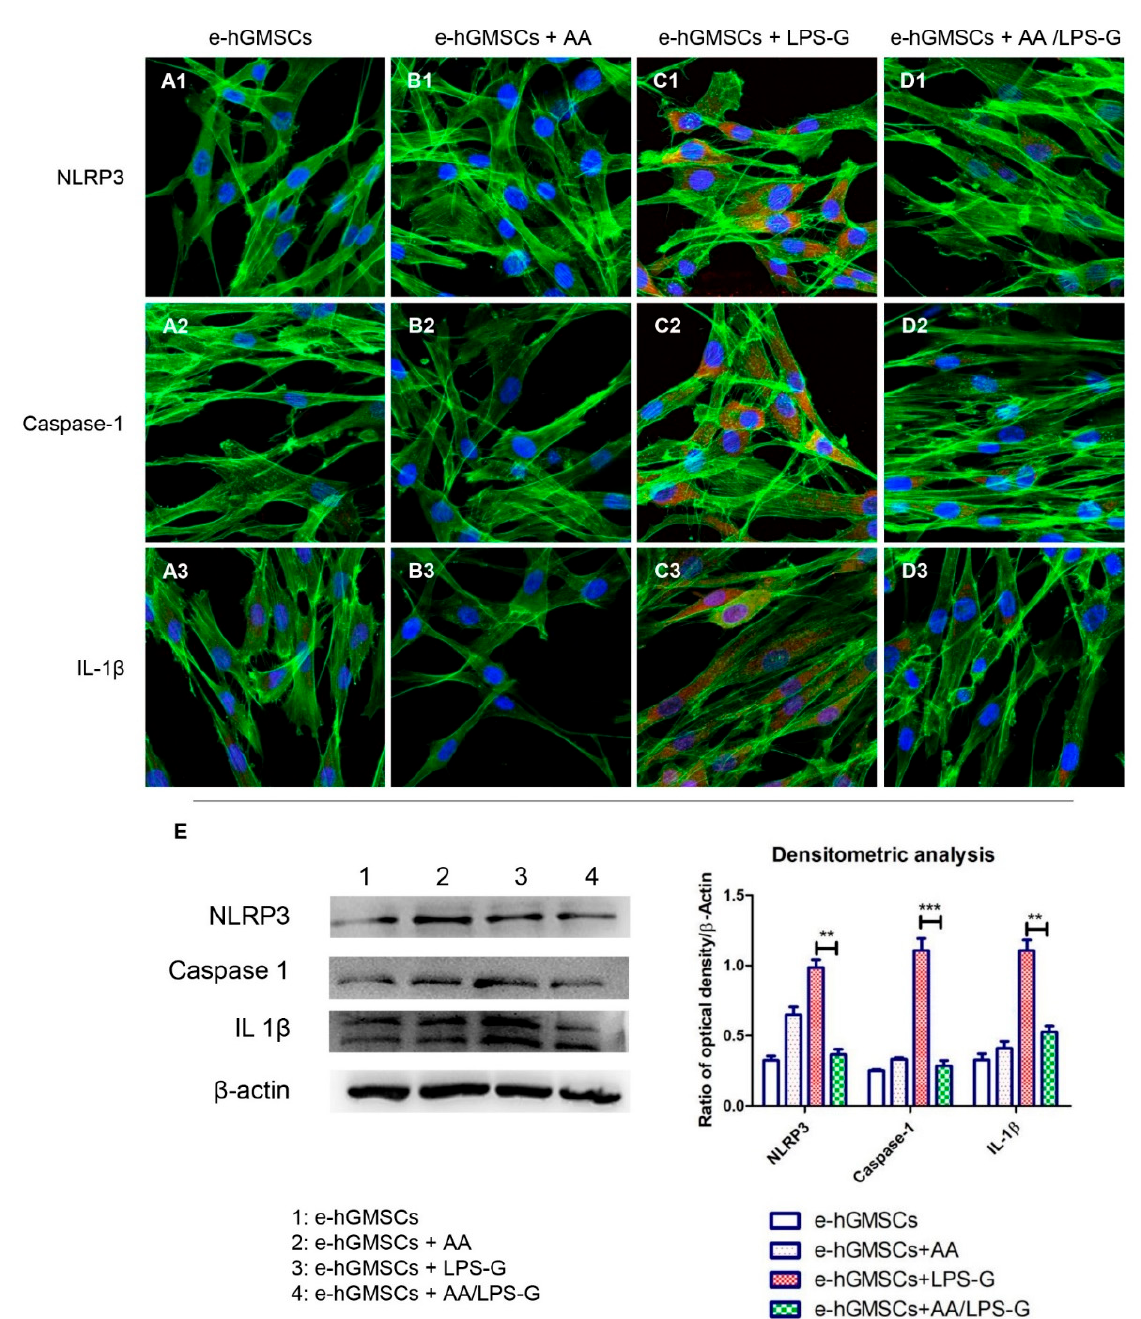
Figure 7. NLRP3/Caspase-1/IL-1 β signaling pathway and differences in protein levels in e-hGMSCs. Expression of NLRP3, Caspase-1 and IL-1 β , examined by confocal microscopy and Western blot experiments. ( A1 – D1 ) NLRP3 expression in e-hGMSCs (CTRL), e-hGMSCs + AA, e-hGMSCs + LPS-G, e-hGMSCs + AA/LPS-G. ( A2 – D2 ) Caspase-1 expression in e-hGMSCs (CTRL), e-hGMSCs + AA, e-hGMSCs + LPS-G, e-hGMSCs + AA/LPS-G. ( A3 – D3 ) IL-1 β expression in e-hGMSCs (CTRL), e-hGMSCs + AA, e-hGMSCs + LPS-G, e-hGMSCs + AA/LPS-G. ( E ) NLRP3, Caspase-1 and IL-1 β protein levels. β -actin was used as a loading control. Green fluorescence: cytoskeleton actin. Red fluorescence: NLRP3, Caspase-1, IL-1 β . Blue fluorescence: cell nuclei. Scale bar: 20 μ m. ** p < 0.01; *** p < 0.001.